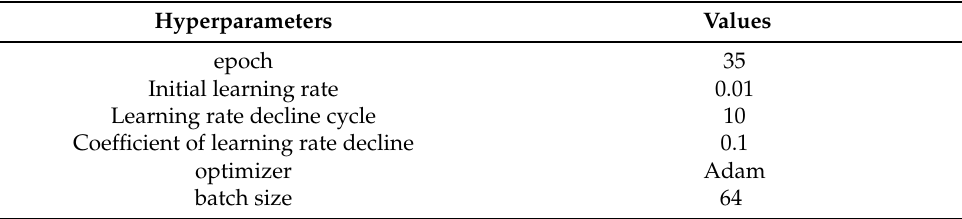
Table 3. The setting of the